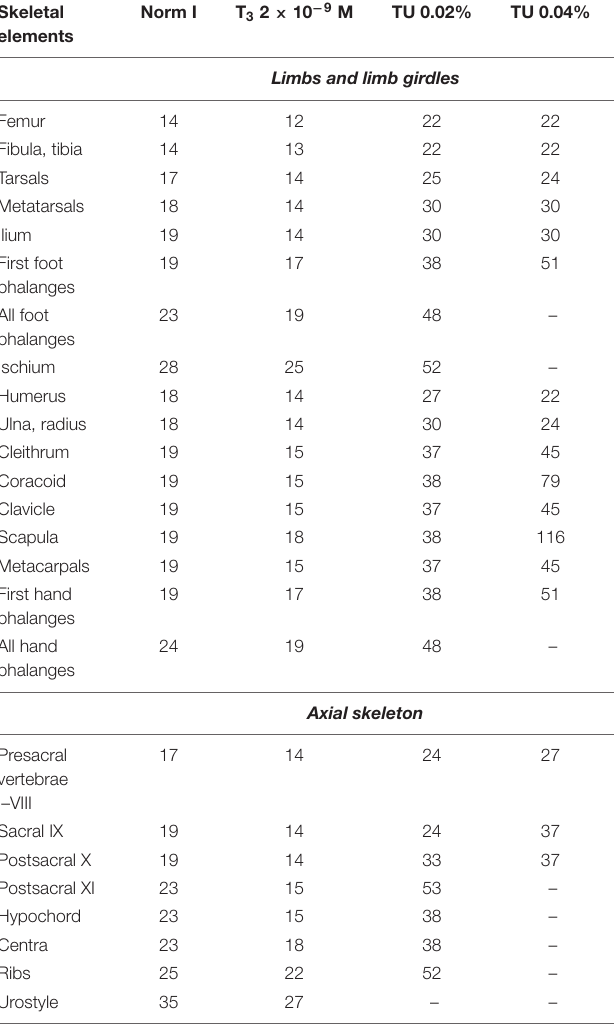
TABLE 5 | Timing (the earliest registration in dph) of the postcranial skeletal elements appearance in larval Bombina variegata under different experimental conditions (Experiment